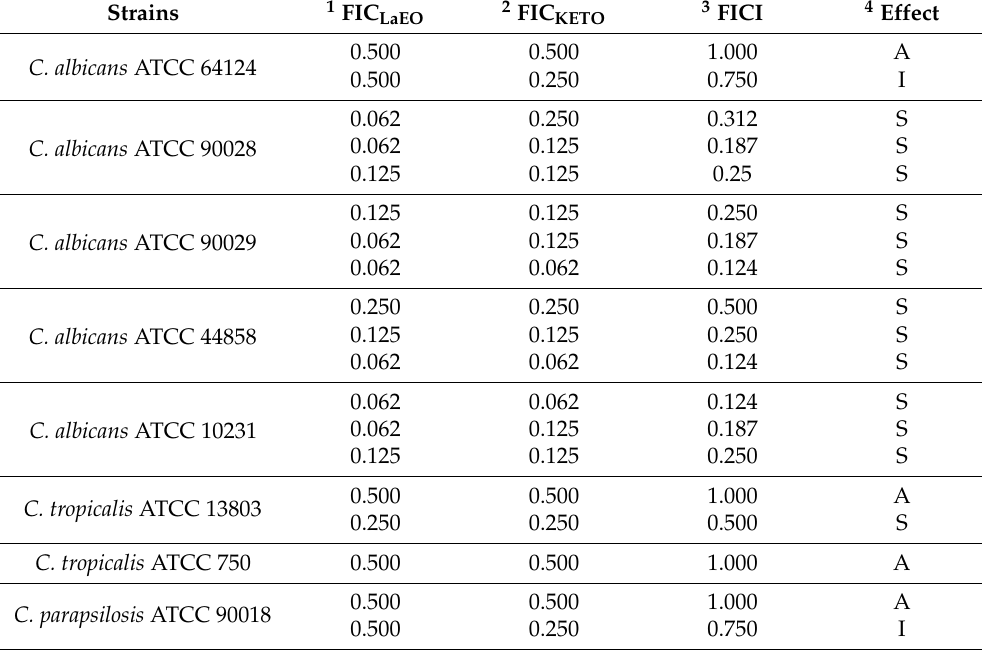
Table 7. Modulatory effect of LaEO on the antifungal activity of ketoconazole (KETO) on Can- dida